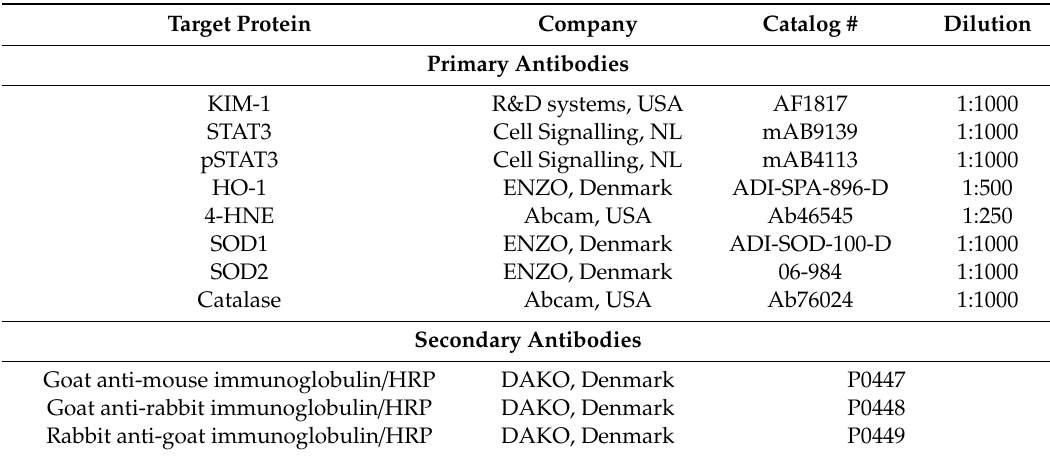
Table 1. Primary and secondary